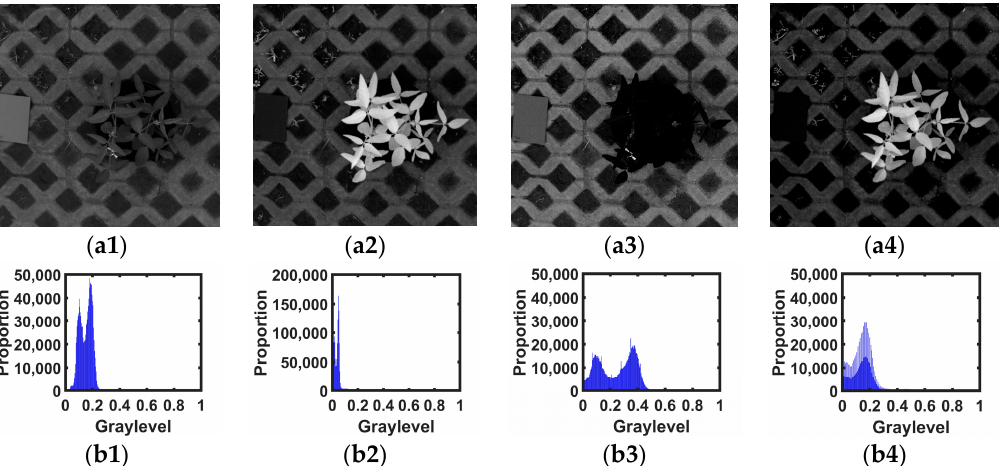
Figure 6. Soybean multispectral reflection image and corresponding histogram: ( a1 ) GRE reflection image, ( a2 ) NIR reflection image, ( a3 ) RED reflection image and ( a4 ) REG reflection image; ( b1 ) GRE histogram, ( b2 ) NIR histogram, ( b3 ) RED histogram and ( b4 ) REG histogram.